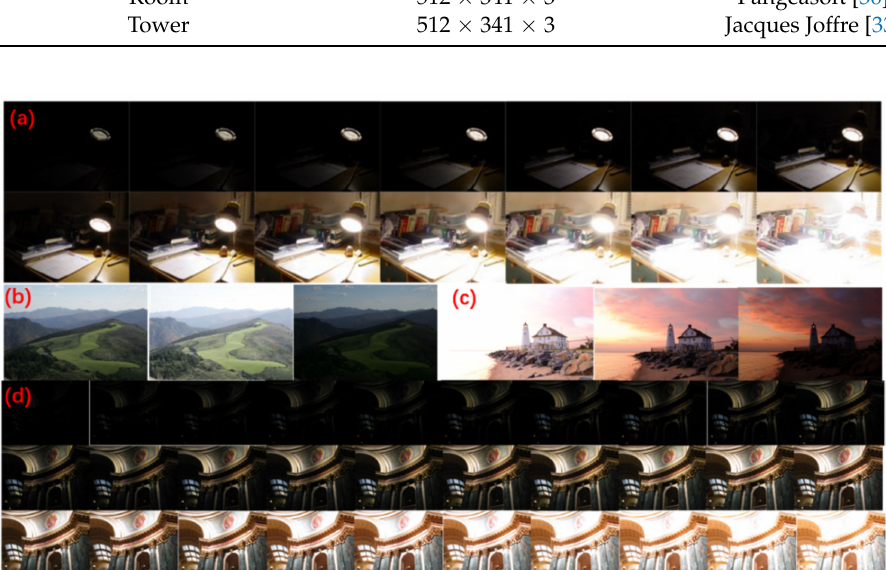
Figure 9. Three sets of multi-exposure image sequences. ( a ) ‘Lamp’ image sequences. ( b ) ‘Landscape’ image sequences. ( c ) ‘Lighthouse’ image sequences. ( d ) ‘Madison Capital’ image